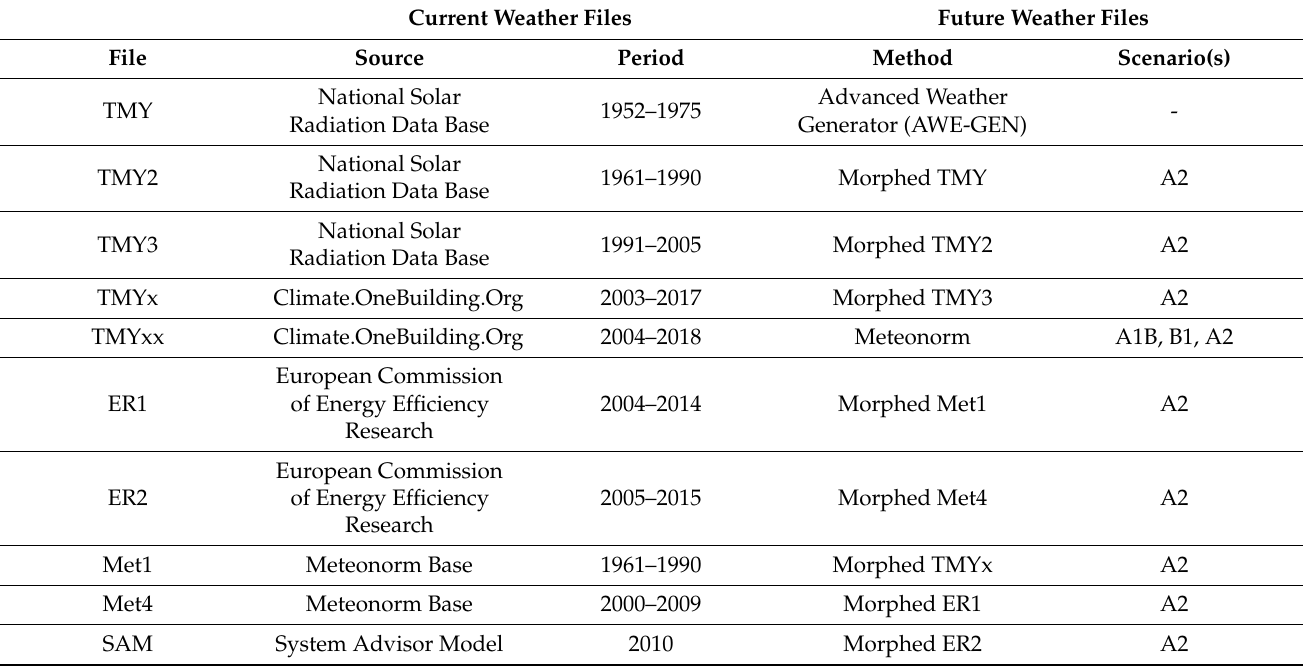
Table A1. Summary of current weather file sources and future weather files method of